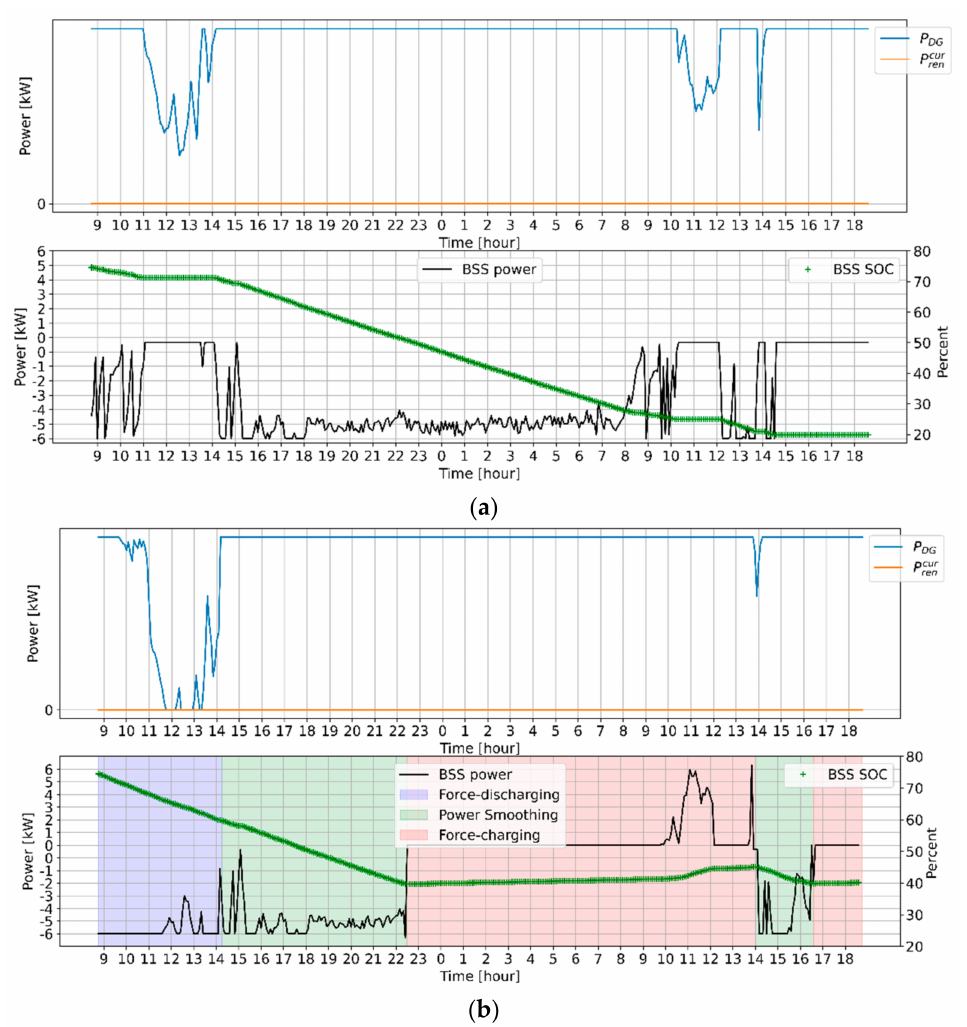
Figure 15. Test results of Case-a: ( a ) MG is dispatched by non-SOC following dispatch rule. ( b ) MG is dispatched by the proposed SOC following dispatch